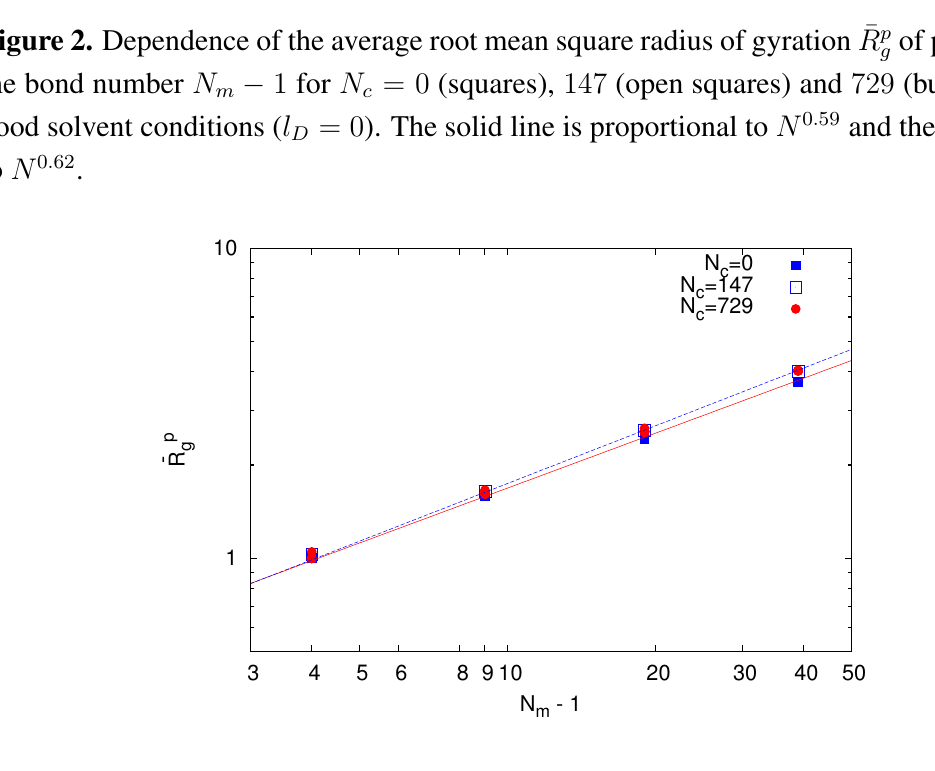
Figure 3. Spherically averaged static structure factor S ( q ) of a microgel with N cross-links and a polymer length N